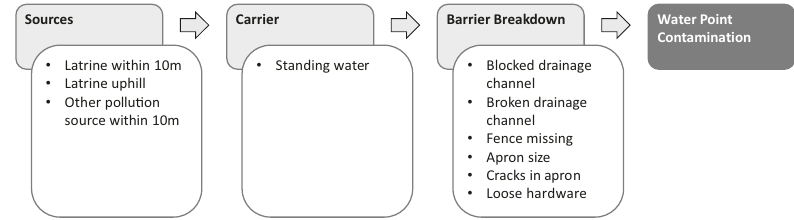
Fig. 3 Theoretical framework to assess sanitary inspection. Each risk factor included in the WHO sanitary inspection for handpump has been classi fi ed as a contamination source, carrier, or breakdown barrier. The framework assumes that at least one contamination source, carrier, and breakdown barrier must all be present to cause water point